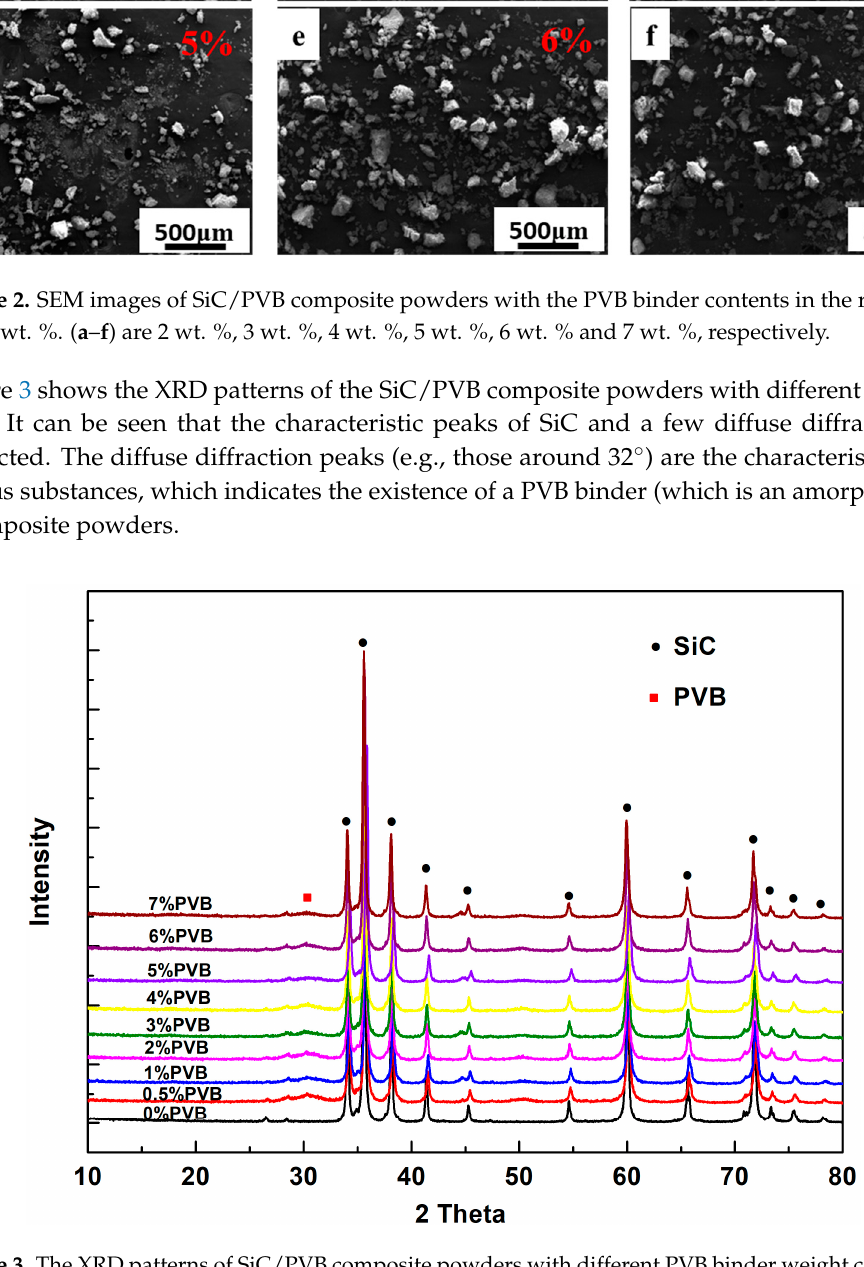
Figure 3. The XRD patterns of SiC/PVB composite powders with different PVB binder weight contents.